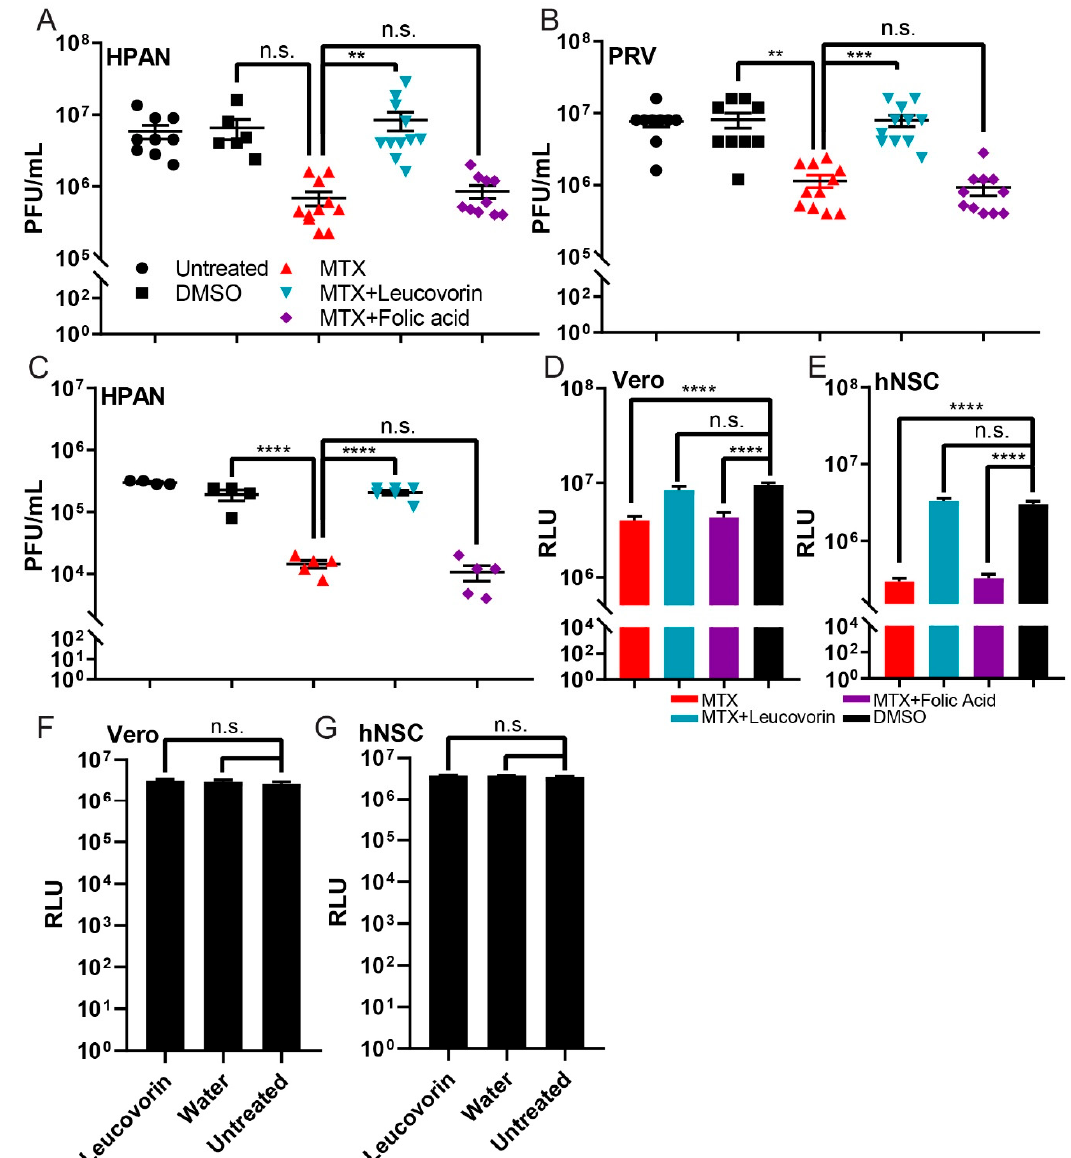
Figure 3. Rescue effect of leucovorin on the cell viability and ZIKV replication during MTX treatment. Two host cell lines, Vero and human neural stem cells (hNSCs), were used to examine the mechanism of action of MTX against ZIKV replication through the DHFR pathway. Virus titers of the two ZIKV strains, H/PAN MOI 0.2 ( A ) and PRV MOI 0.2 ( B ) on Vero cells were measured by standard plaque assay. With H/PAN infection, the ZIKV titer of the DMSO control was not significantly different from that of 5 µ M MTX-treated sample in Vero cells ( p = 0.11) ( C ) Virus titer of H/PAN MOI 0.1 on hNSCs was measured by standard plaque assay. ( D ) The cytotoxicity of 5 µ M MTX and co-treatment of MTX with 50 µ M folic acid or leucovorin on Vero cells was studied by CTG reagent. ( E ) The cytotoxicity of 5 µ M MTX and co-treatment of MTX with 50 µ M folic acid or leucovorin on hNSCs was studied by CTG reagent. ( F , G ) 50 µ M Leucovorin and water, as a vehicle control, were added to Vero cells and hNSCs to determine their effect on host cell viability using CTG reagent. RLU = relative luminescence units. At least two independent replicates were performed. One-way ANOVA, followed by Tukey’s multiple comparisons test, were used for statistical analysis. The error bars represent the standard error of the mean (SEM). ** p ≤ 0.01, *** p ≤ 0.001, **** p ≤ 0.0001, n.s. not significant.